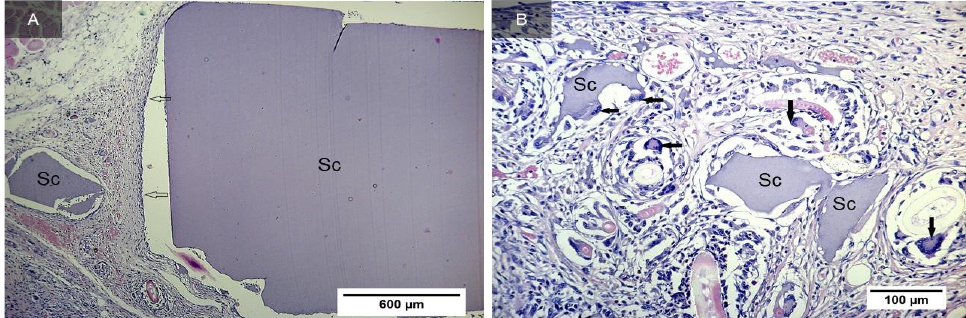
Figure 5. Implant from the synthesized GelMA in the subcutaneous tissue of rats after 10 days (indicated by the letters Sc). The capsule is shown by arrows. Staining with hematoxylin and eosin. Magnification of the image — ×5 ( A ). Fragments of an implant in a connective tissue capsule (indicated by the letters Sc) surrounded by multinucleated macrophages (shown by arrows). Staining with hematoxylin and eosin. Magnification of the image — ×20 ( B ).